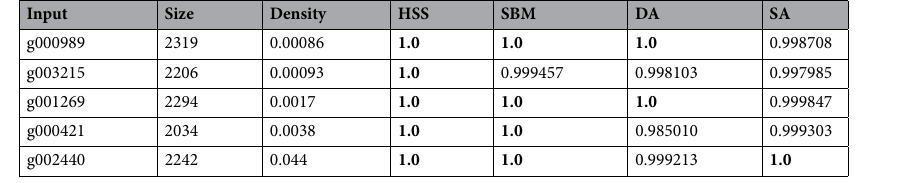
Table 1. Values of score, defined by Eq. (4) for small and sparse classes. The first row shows the instance name, the second row presents the number of variables, the third row contains the edge density, and the fourth and subsequent rows show the results for each solver. The values are computed in single precision from the obtained solution of binary variables; they are shown with six decimal places. The best solutions obtained in this benchmarking are shown in bold.